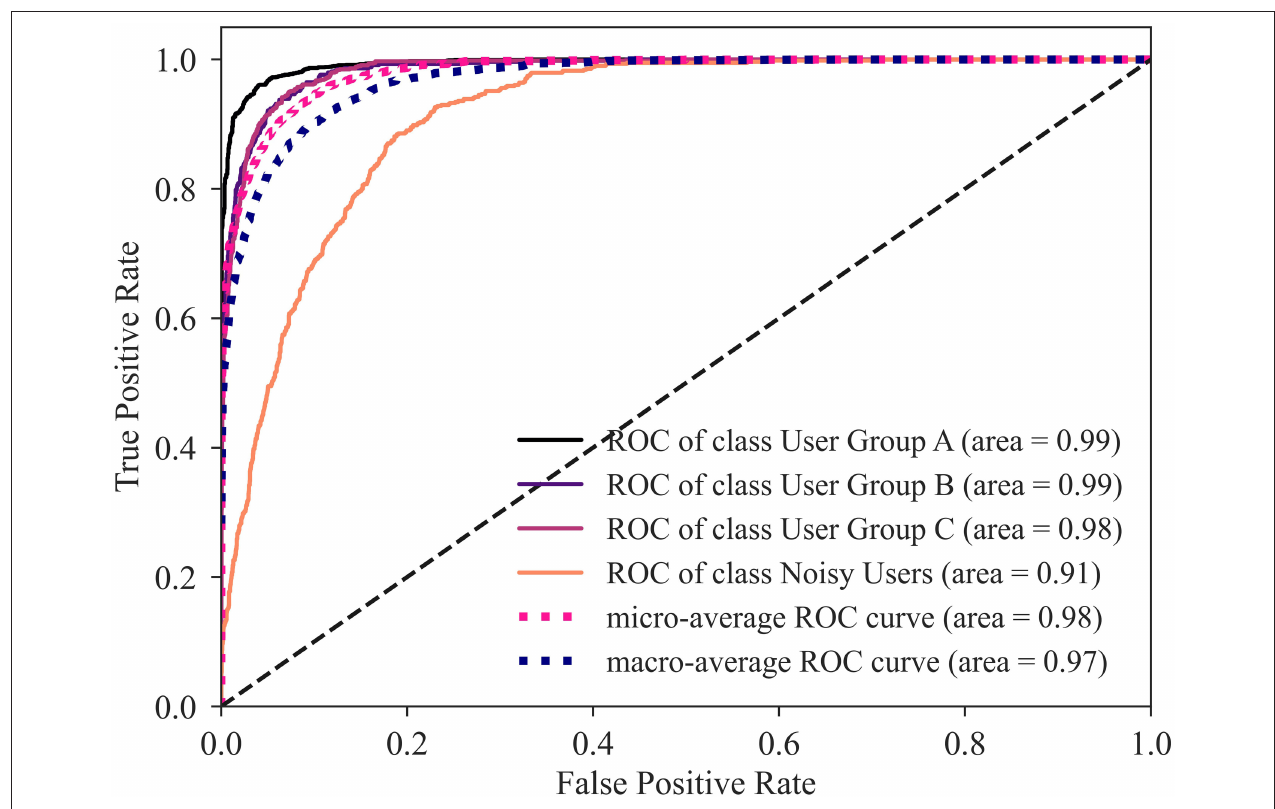
FIGURE 8 | ROC-AUC plot for the ensemble of classifiers, illustrating the tradeoff between sensitivity (True Positive Rate) and specificity (False Positive Rate). The ideal point is the top-left corner, higher AUC is better. In this multiclass scenario, the individual classes are first binarized, the individual scores are computed for each user group, then micro-averages and macro-averages are calculated for each